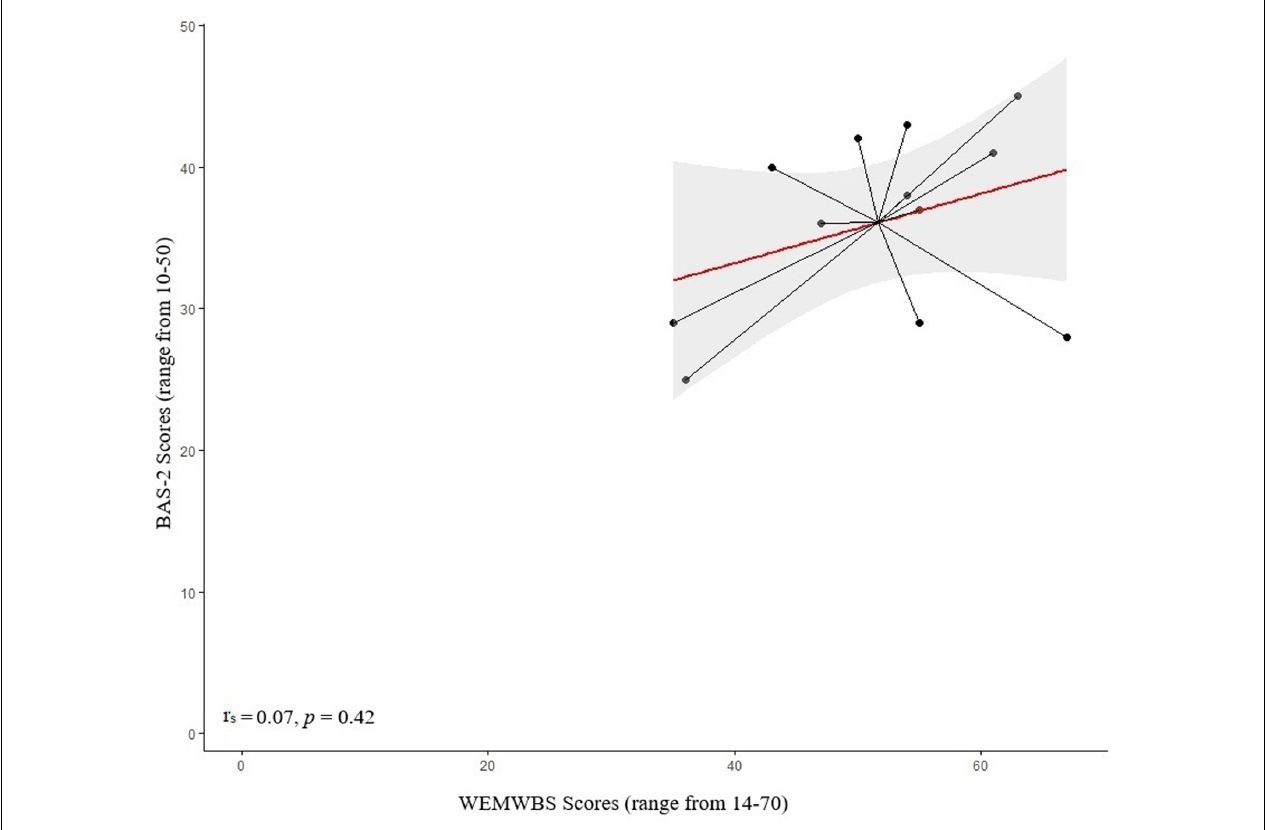
FIGURE 2 | Scatterplot of the mean values for the control sample of pre-intervention ratings on the wellbeing (WEMWBS; scale ranges from 14–70; a higher score indicates higher wellbeing) and the body appreciation scale (scale ranges from 10–50; a higher score indicates higher